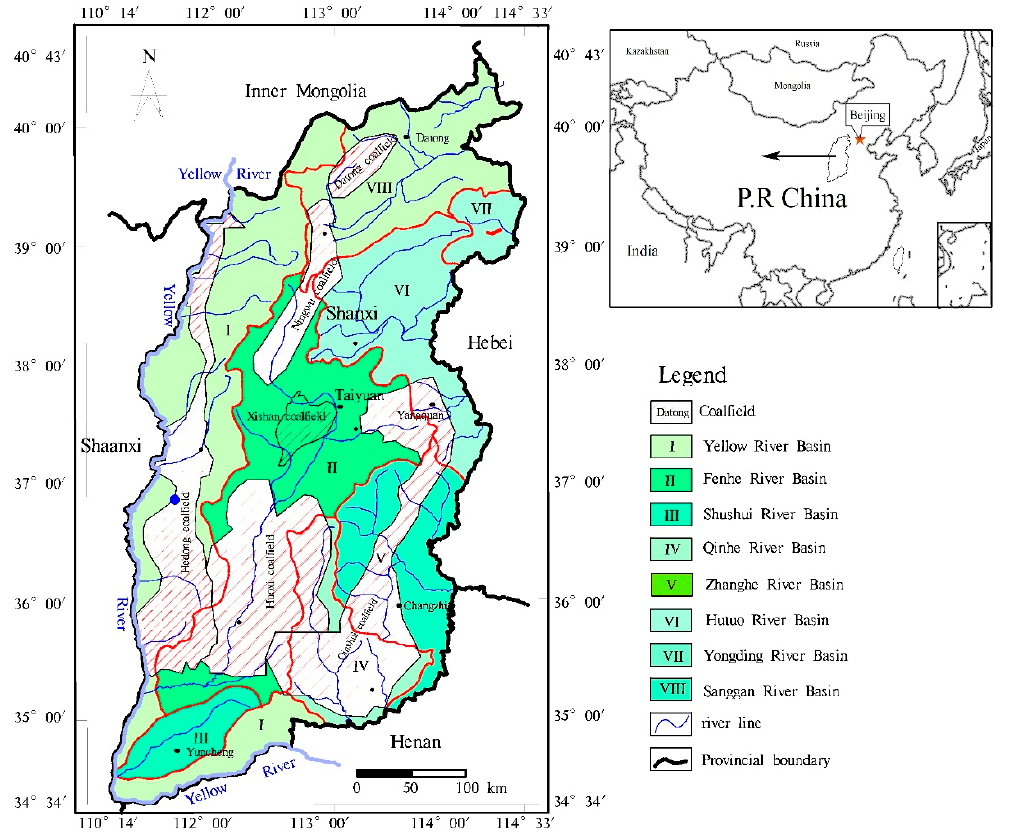
Figure 1. Six major coal fields in Shanxi.